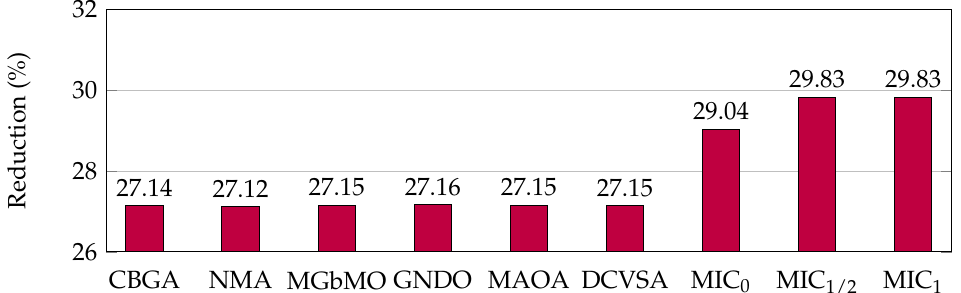
Figure 6. Reduction percentage for each solution methodology with respect to the benchmark case in the IEEE 69-bus